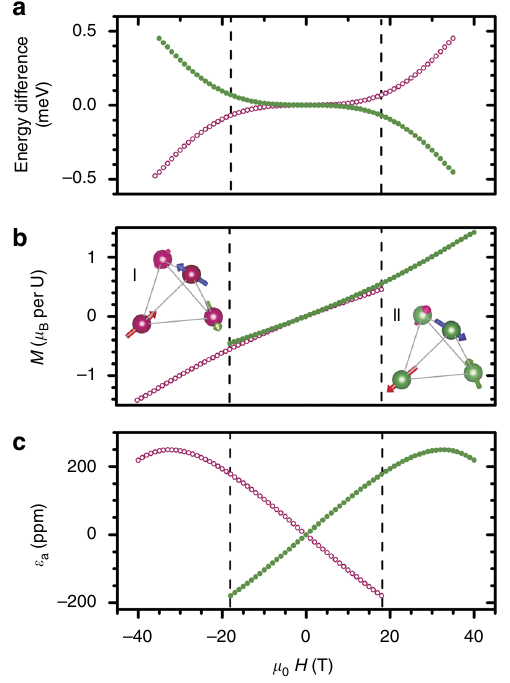
Fig. 4 Model results. a Energy difference vs. magnetic fi eld μ 0 H applied along [111] calculated with our model Hamiltonian at T = 0 for two magnetic states of the 3- k structure connected by time reversal. While the two states are degenerate in zero fi eld, a sign-dependent difference builds up as the fi eld is increased. b Magnetization M vs. fi eld, showing a relatively small yet fi nite difference between states. The dashed lines , placed at the experimental switching fi elds of ± 18 T, are guides to the eye. c Magnetostriction vs. fi eld, showing large difference between states connected by time reversal in very good agreement with experimental results. The insets I and II show the two magnetic states of the 3- k structure connected by time reversal. The color of the four U atoms in the unit cells ( green or red ) matches the corresponding color of the curves